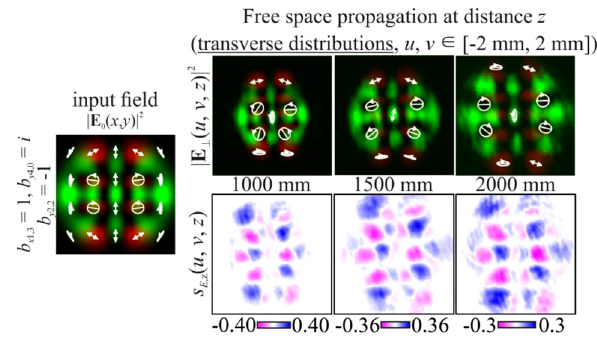
Figure 11: Experimental results for an inhomogeneously polarized two-mode HG beam defined by Eq. (27) with indices ( n + m ) ≠ ( p + q ).